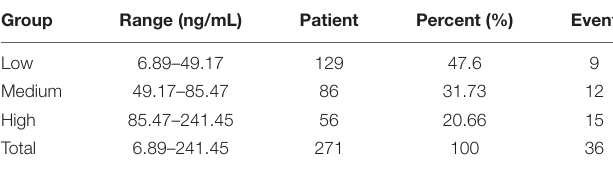
TABLE 1 | Cut-off point of MPO by X-tile